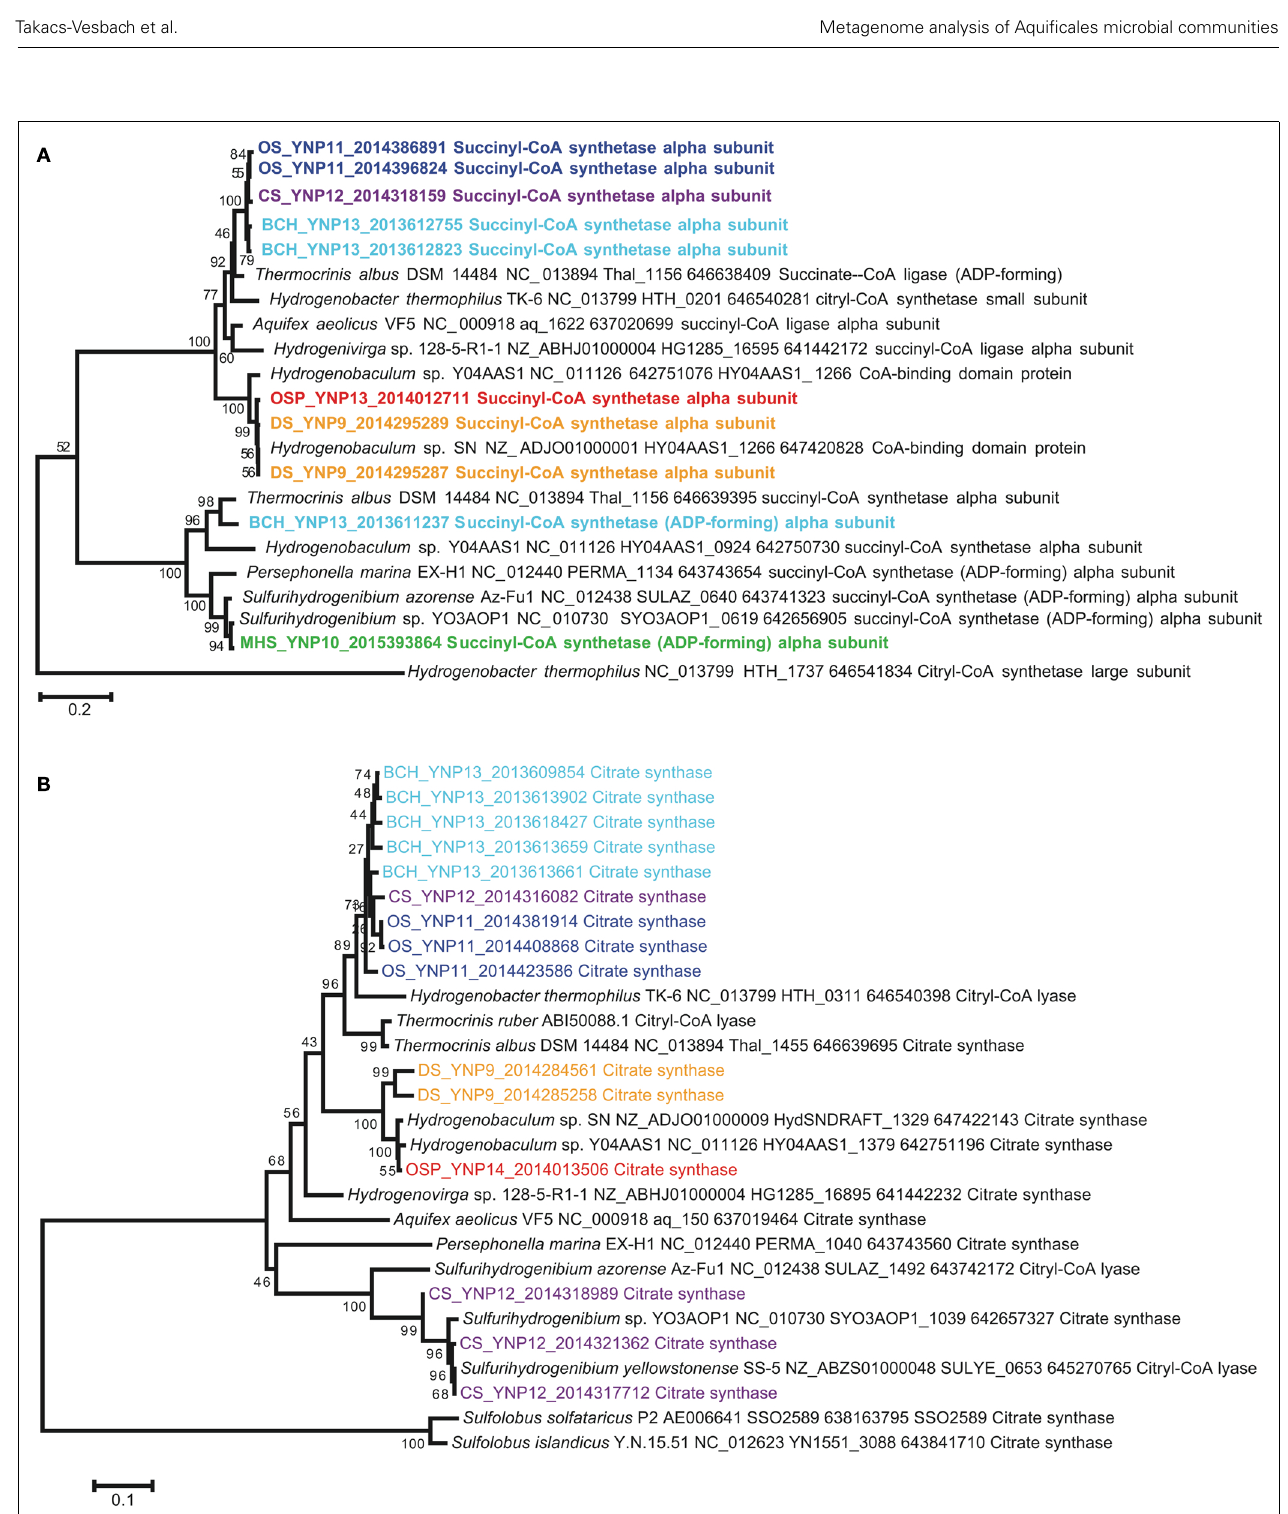
FIGURE 8 | Deduced protein tree of (A) citryl-coA synthetase (CcsA), and (B) citryl-CoA lyase (Ccl) showing metagenome entries fromAquificales sites (neighbor-joining tree with 1000 bootstraps) .